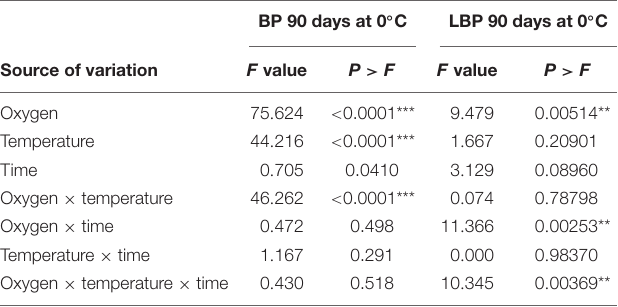
TABLE 2 | Individual effect and interactions of conditioning treatments: oxygen concentration (0.5 and 21 kPa), temperature (0 and 5 ◦ C), and conditioning time (15 and 30 days) in ‘Fuji’ apples for the incidence of bitter pit (BP) stored during 90 days at 0 ◦